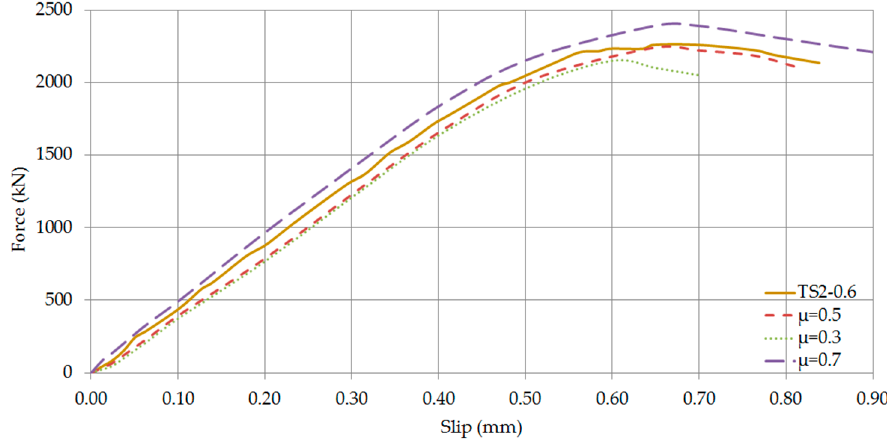
Figure 25. Axial force—Slip Curves of TS1-1.2 (Comparison of friction coefficients).